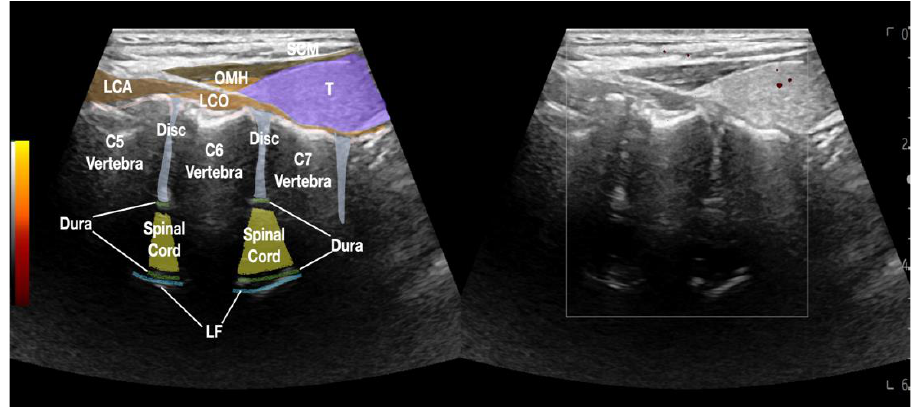
Figure 1. The figure depicts the sonoanatomy of the anterior cervical spine with the transducer in the sagittal plane of the cervical spine in the fascial plane between the carotid artery and the thyroid. Osteophytes were formed at the annulus fibrosus of the C5/6 and C6/7 discs. Visible parts of the anterior and posterior dura and spinal cord are also labeled. Abbreviations: LCA — longus capitis muscle; LCO — longus coli muscle; LF — ligamentum flavum; OMH — omohyoid muscle; SCM — sternocleidomastoid muscle; Spinal Cord — visible parts of spinal cord; T — thyroid gland.